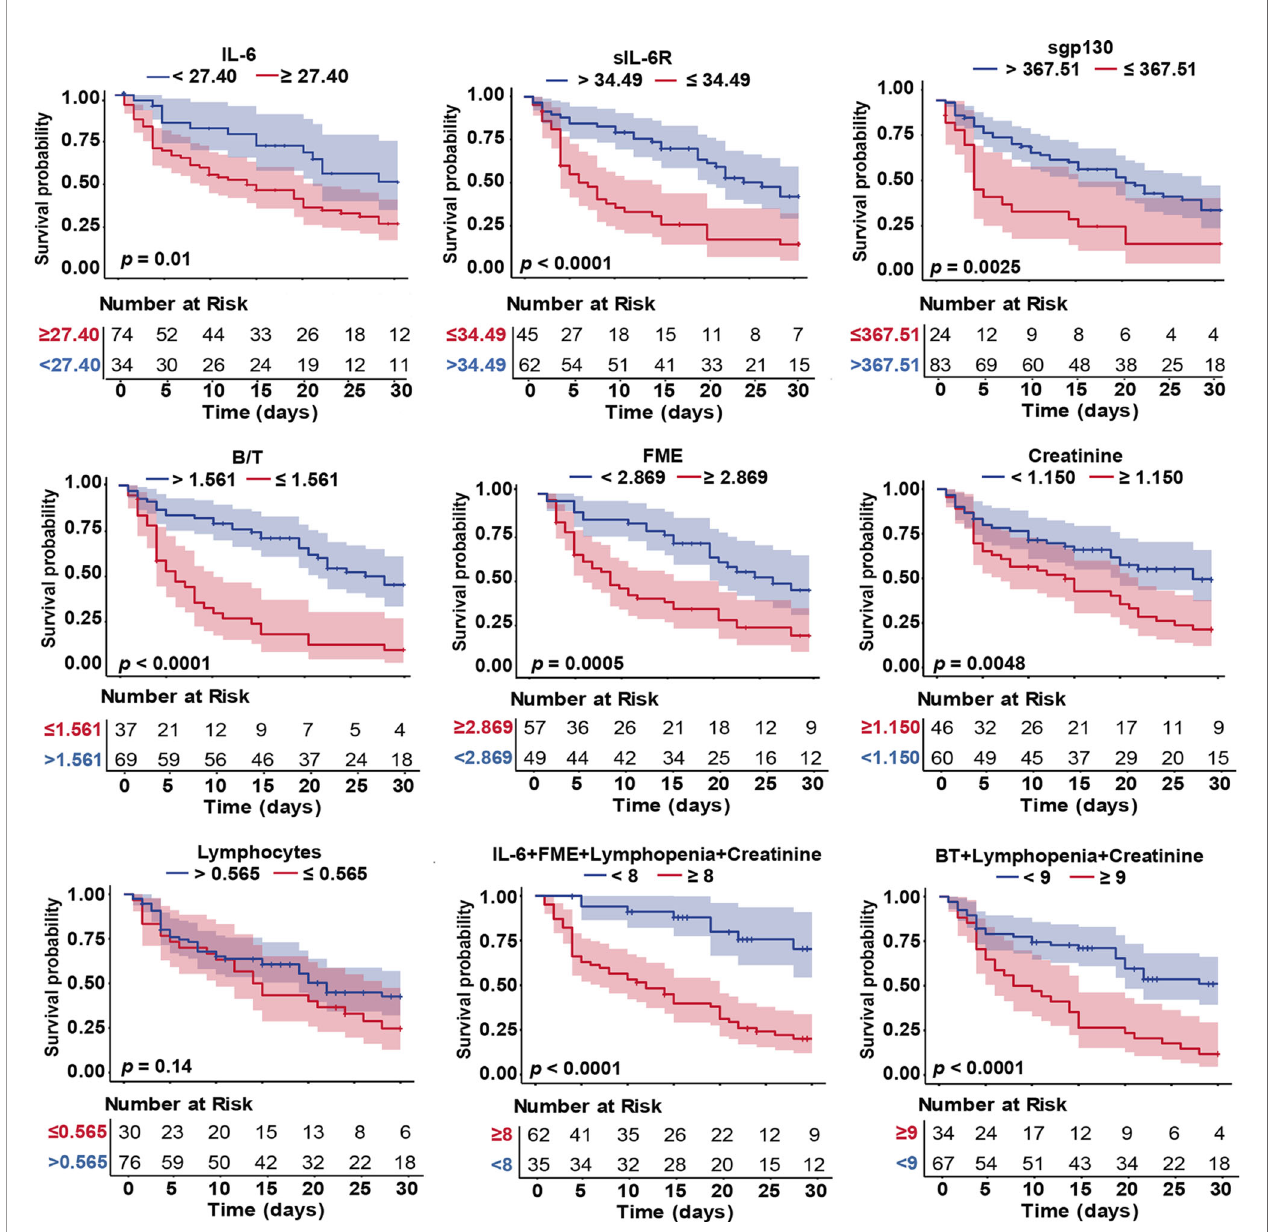
FIGURE 4 | Kaplan-Meier curves of IL-6 signalling biomarkers, biochemical data and composite risk scores in COVID-19 severe patients. Parameters of Kaplan- Meier survival analysis: events (death); time to events (time from hospital admission to death) and end-point (30-day). Differences in time to death curves were compared with the log-rank/Breslow tests. Colour shades represent the 95%